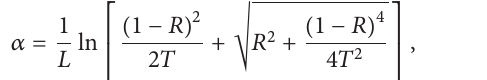
the transmission curves to meet 𝜆 axis and are listed in Table 1. The values of 𝜆 cutoff decrease with the increase in ZnO content. The values of absorption coefficient ( 𝛼 ) of the glass samples have been estimated using Beer-Lambert law